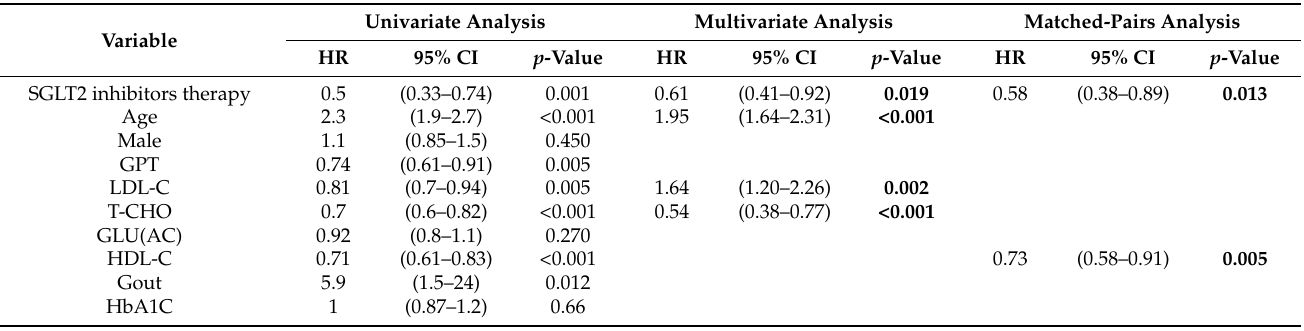
Table 2. Univariate and multivariate analyses of total cardiac arrhythmia incidence in the study patients.